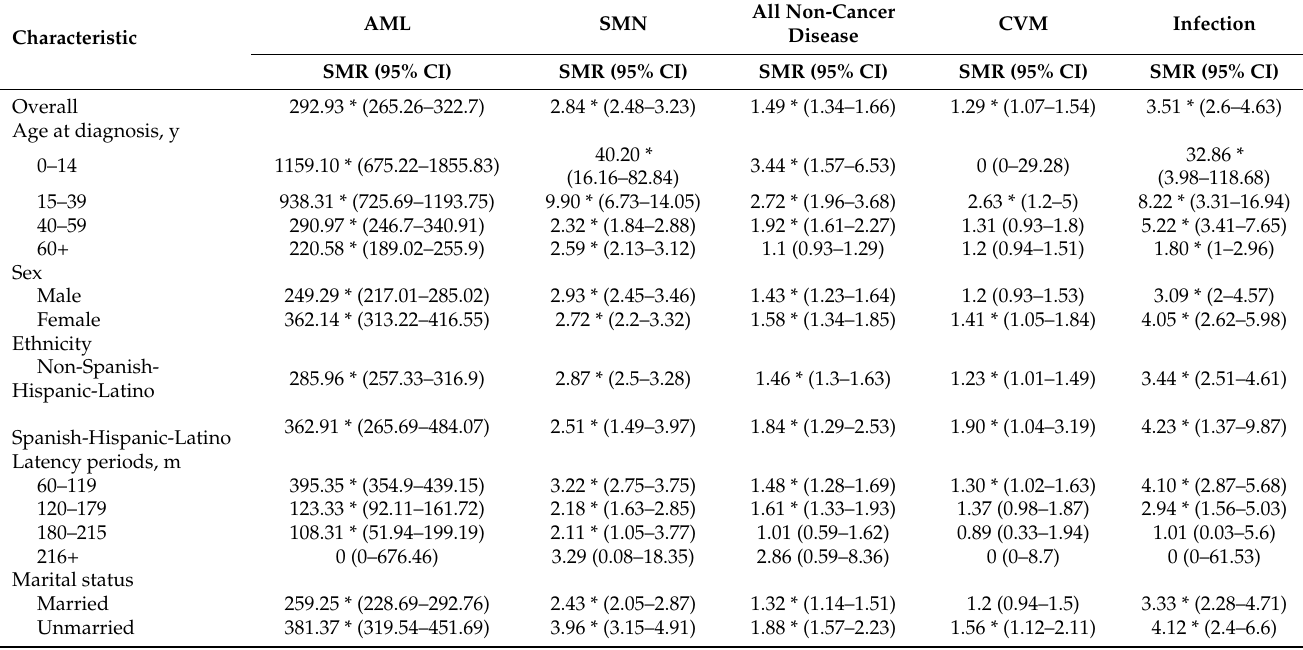
Table 3. Standardized mortality ratios (SMRs) for 5-year survivors of non-APL AML according to baseline characteristics.